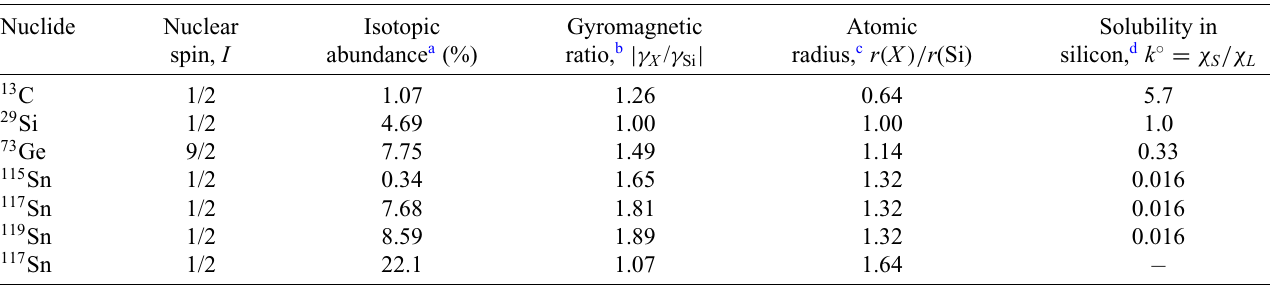
TABLE I. The properties of stable finite-spin group-IV